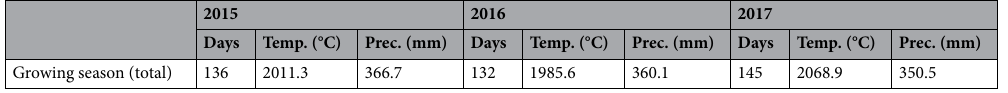
Table 1. The duration of growing seasons (Days), sum of temperatures (Temp.) and sum of precipitation (Prec.) during the growth and development of T. durum Desf. in the analyzed years.